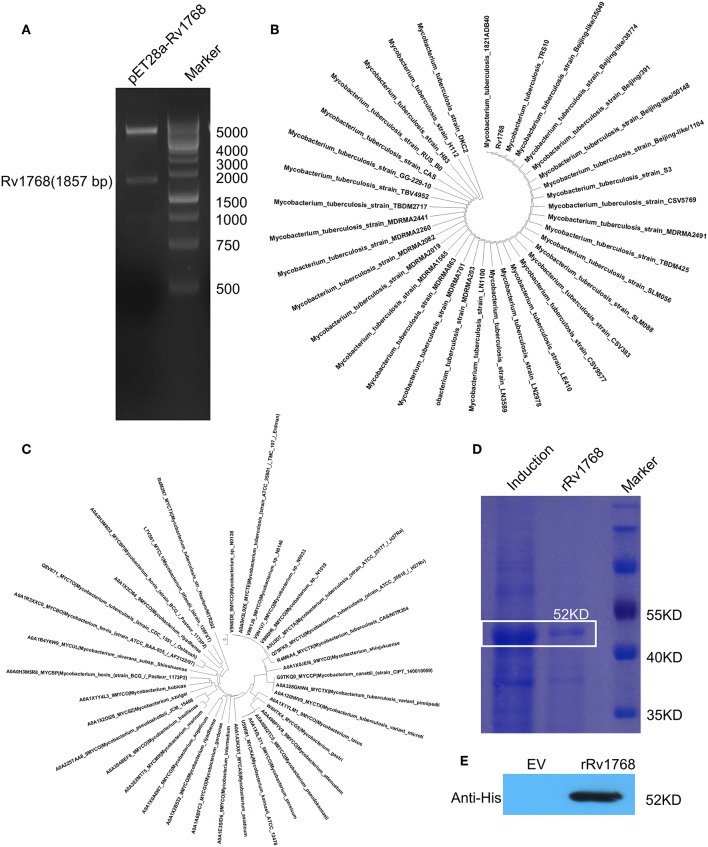
Expression and purification of Rv1768. (A) Double enzyme digestion of recombinant plasmid pET28a-Rv1768. (B) Phylogenetic analysis of Rv1768 CDS sequence in mycobacterial species acquired by blasting of M.tb Rv1768 (https://mycobrowser.epfl.ch/genes/Rv1768) against NCBI database. (C) Phylogenetic analysis of Rv1768 homologs in mycobacterial species acquired by blasting of M.tb Rv1768 (Q79FK9_MYCTU) against UniProtKB_Bacteria database. (D) Purification and SDS-PAGE of Rv1768. (E) Western blot identification of Rv1768 with anti-His mAb, empty vector (EV) was used as a control.